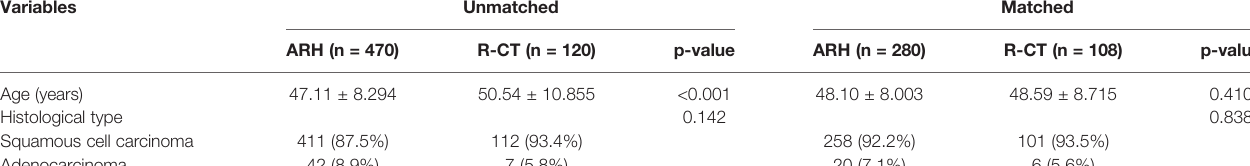
TABLE 1 | Data of the ARH group and R-CT group patients before and after matching. Variables